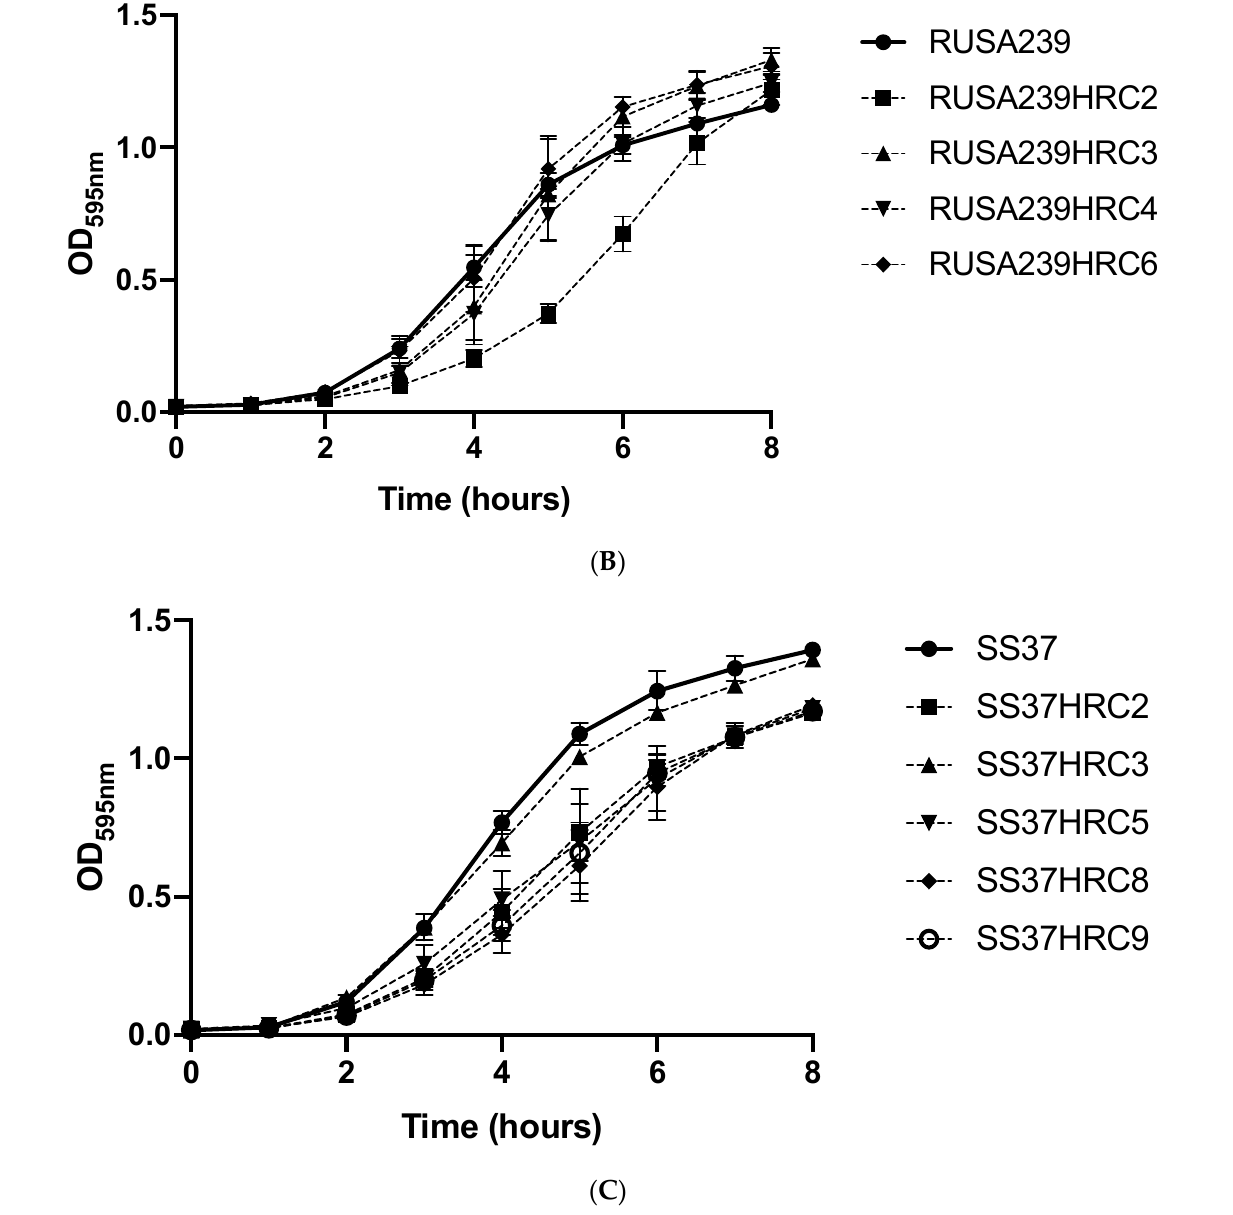
Figure 3. Growth curves of ( A ) LGA251, ( B ) RUSA239, and ( C ) SS37 parental heteroresistant populations and the respective H*R sub-populations. Bacterial cultures were grown in TSB at 37 °C with aeration. All points represent the geometric mean of three technical plus three biological triplicates. Error bars represent 95% confidence intervals.